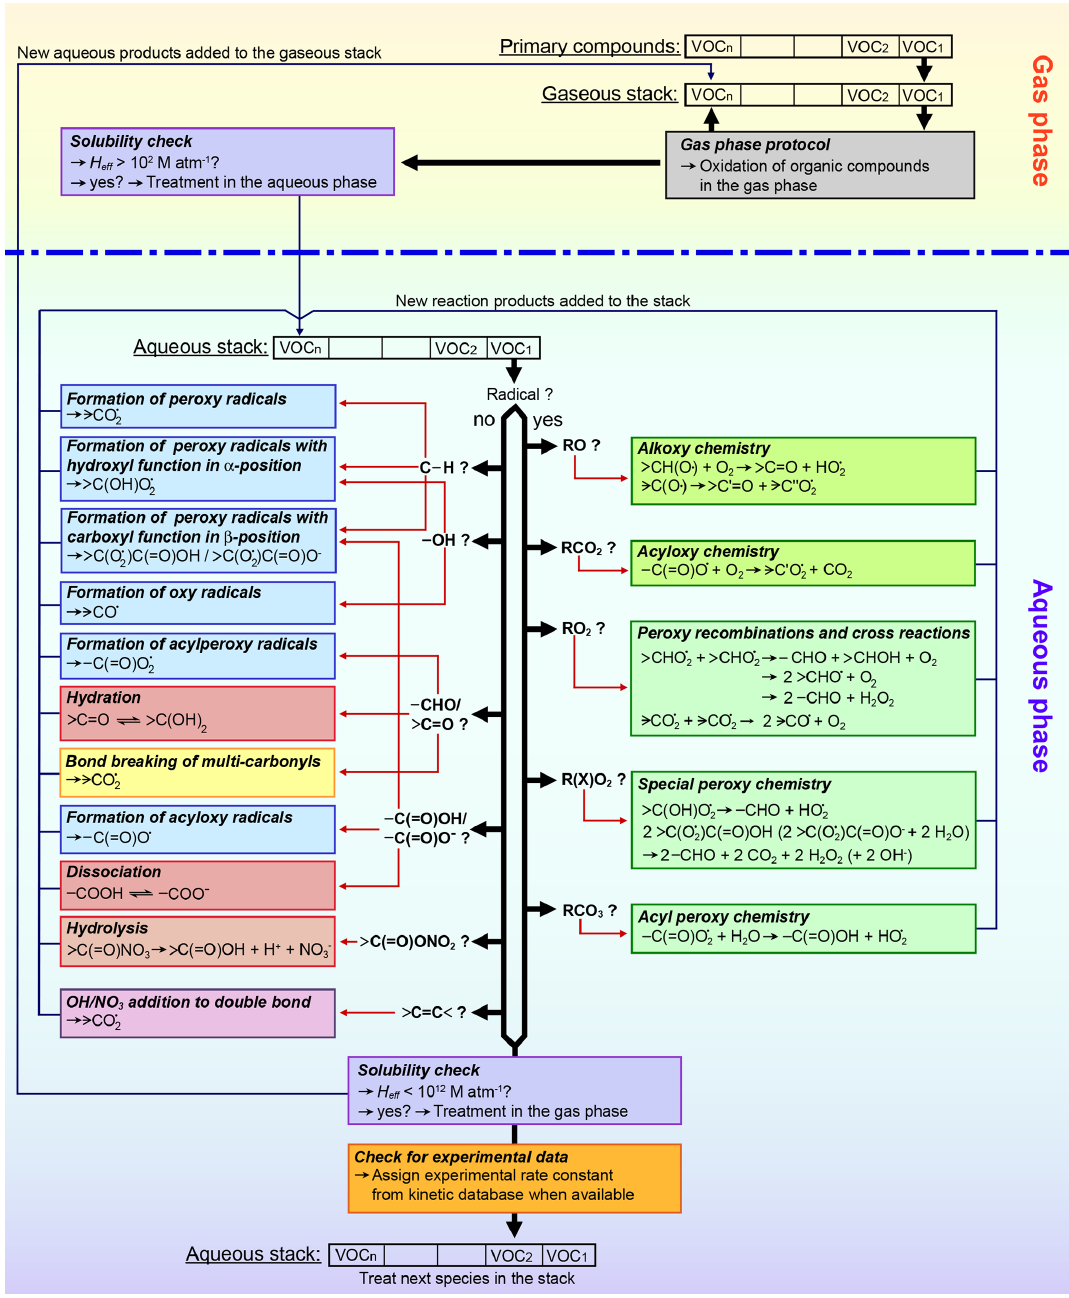
Figure 17. Workflow of the generator GECKO-A with the processes implemented in the aqueous-phase protocol. Blue boxes represent H abstraction reactions, the pink box represents radical addition to double bonds of unsaturated organic compounds, red boxes represent equilibria, the yellow box represents C–C bond breaking of poly-carbonyls, the light brown box represents the hydrolysis of carbonyl nitrates, and green boxes represent radical chemistry (different shades differentiate between oxy and peroxy radical